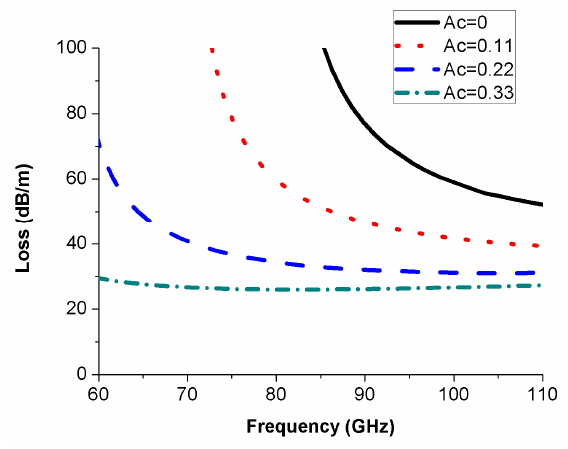
Figure 5. Coupling impedance of the CV-FWG for various values of d .